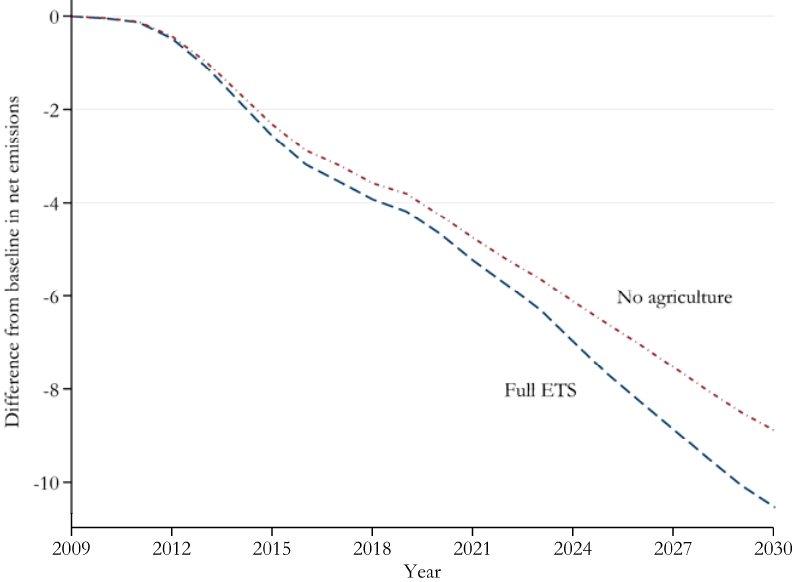
Figure 4. Annual differences from baseline in the net flow of emissions from forestry (in gigagrams of CO ). All pre-1990 and post-1989 forest on private land is 2